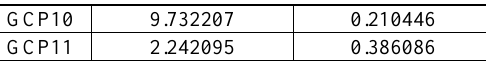
Table 2. The accuracy of self-calibration solution